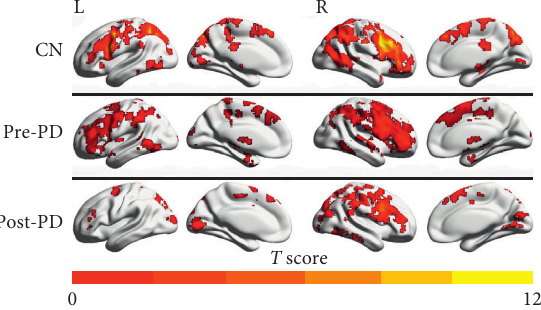
Figure 1: Functional connectivity of the brain network patterns for CN, pre-PD, and post-PD using resting-state functional magnetic resonance imaging (rs-fMRI). Group-level analyses led to three intrinsic connectivity maps. The results are presented using FDR corrected p < 0 . 001 and cluster extent k > 30 voxels (810 mm 3